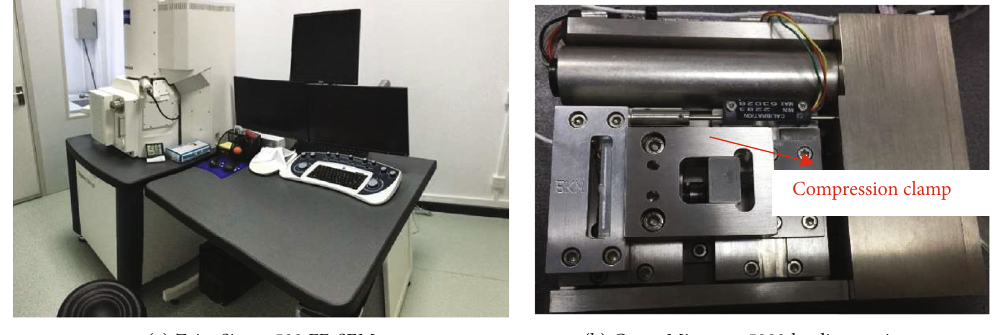
Figure 1: 2D in situ loading scanning